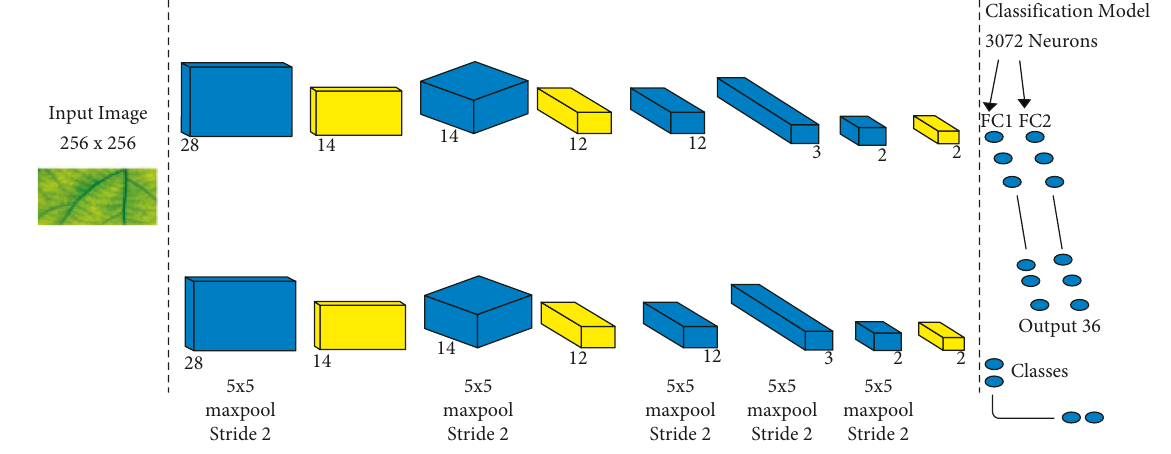
Figure 6: Proposed CNN